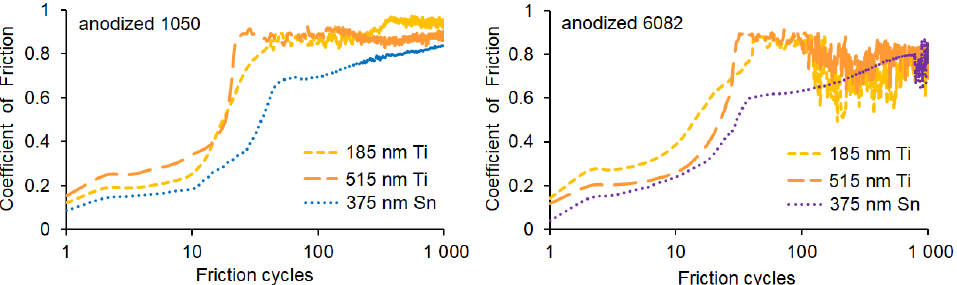
Figure 7. Comparison of friction trends of Sn and Ti layers sputtered on anodic coatings of 1050 ( left ) and 6082 ( right ) alloys at 185 – 515 nm thickness.